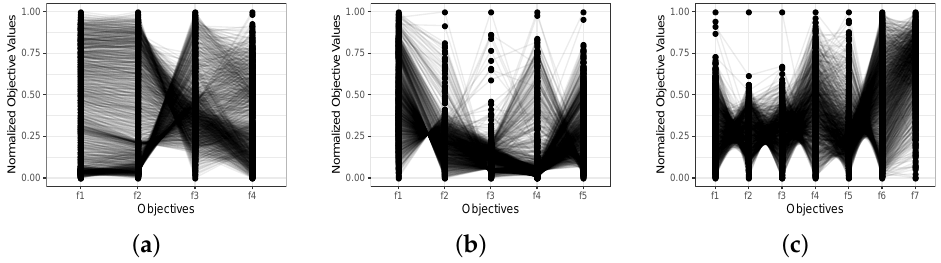
Figure 5. Parallel coordinate plots for the three real-world applications. ( a ) RWA1; ( b ) RWA2; ( c )